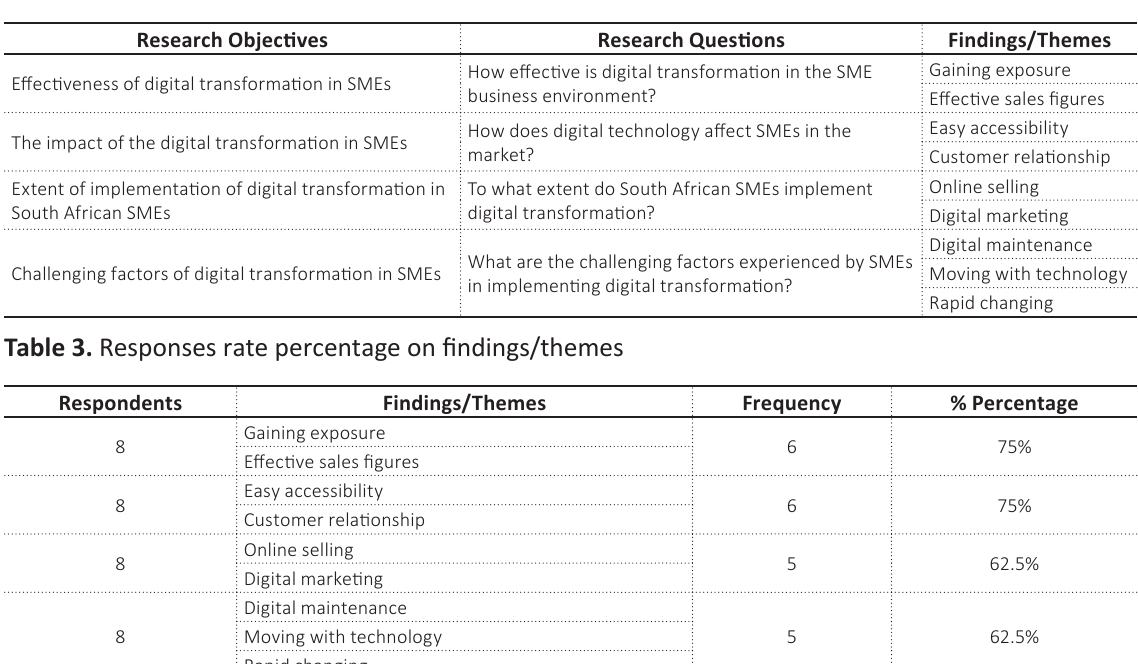
Table 2. Linking of research objectives, questions, and findings